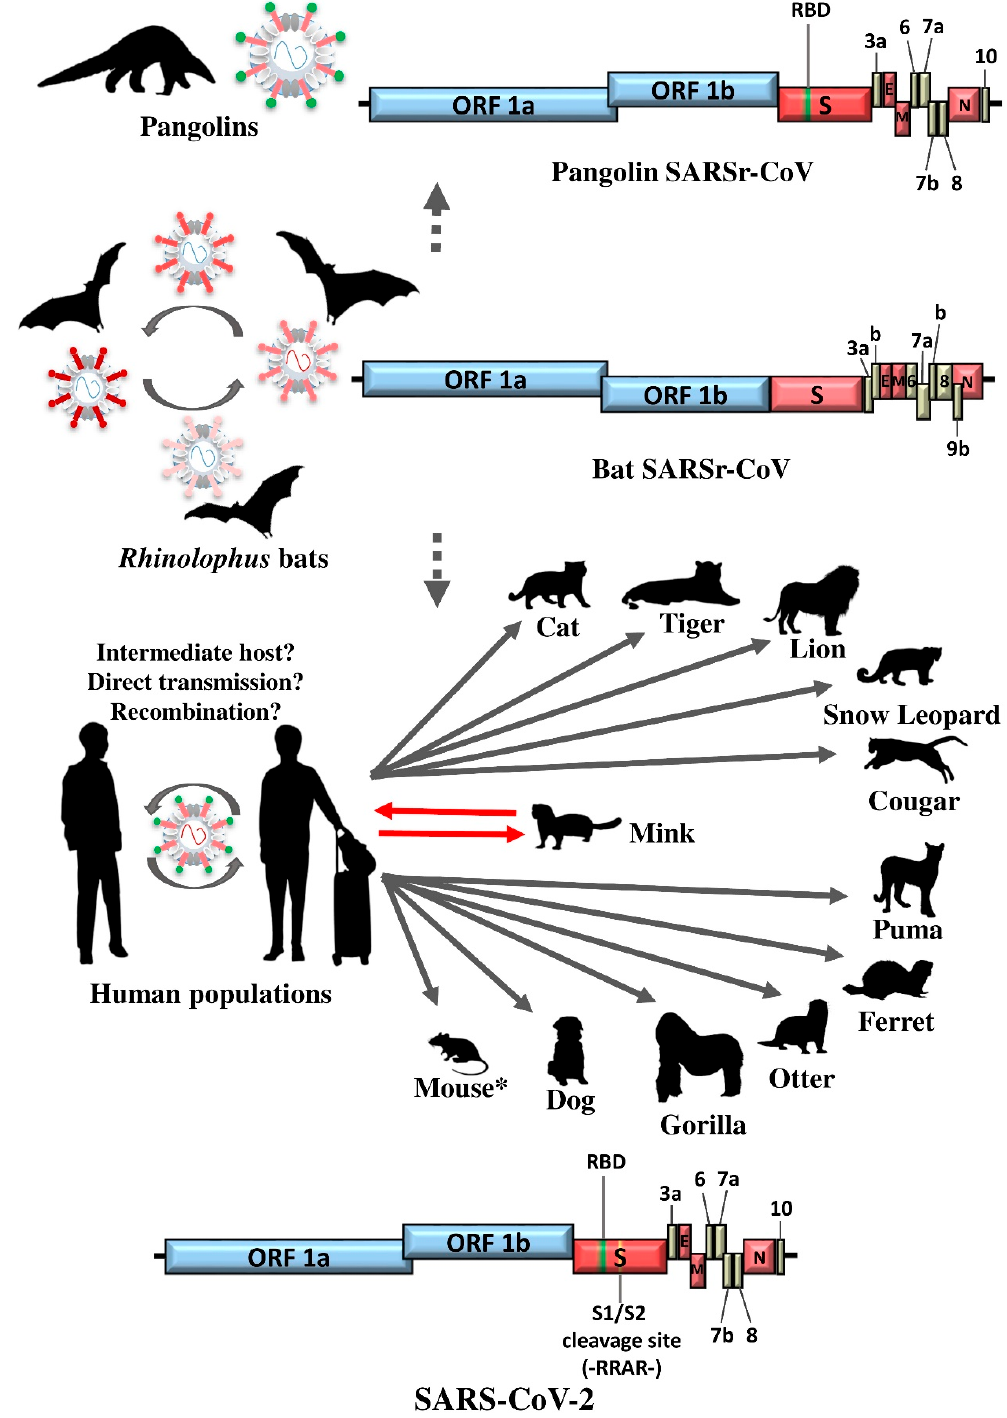
Figure 7. Overview of interspecies transmission events of COVID-19 pandemic since 2019. Arrows indicate the direction of viral interspecies jumping and viral molecular evolution between different host species. Circular arrows indicate the circulation of virus within the population. Dot arrows indicate the viral interspecies jumping event remains to be elucidated. Red arrows indicate the bi-directionality of interspecies jumping events. Asterisk labeled animal represents the laboratory interspecies jumping event through host adaption. ORF1a and ORF1b are represented by blue boxes, structural proteins by red boxes, and accessory proteins by yellow boxes. The RBD and the -RRAR- cleavage site are highlighted in green and yellow respectively.